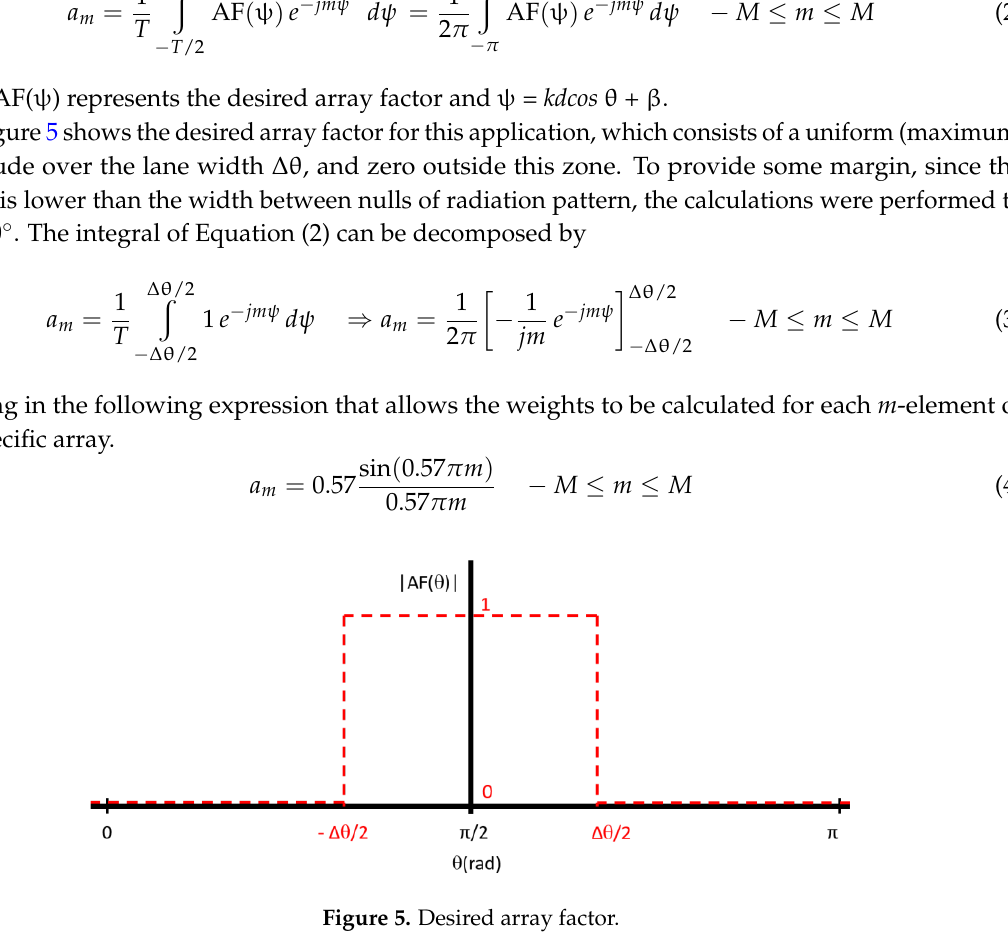
Figure 6. Variation of theoretical array response with the number of elements of the array, using Fourier transform method (FTM) coefficients.